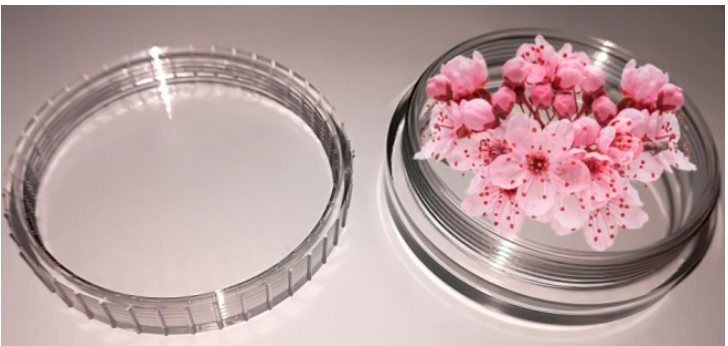
Figure 1. Polycarbonate capsule used for flowers.